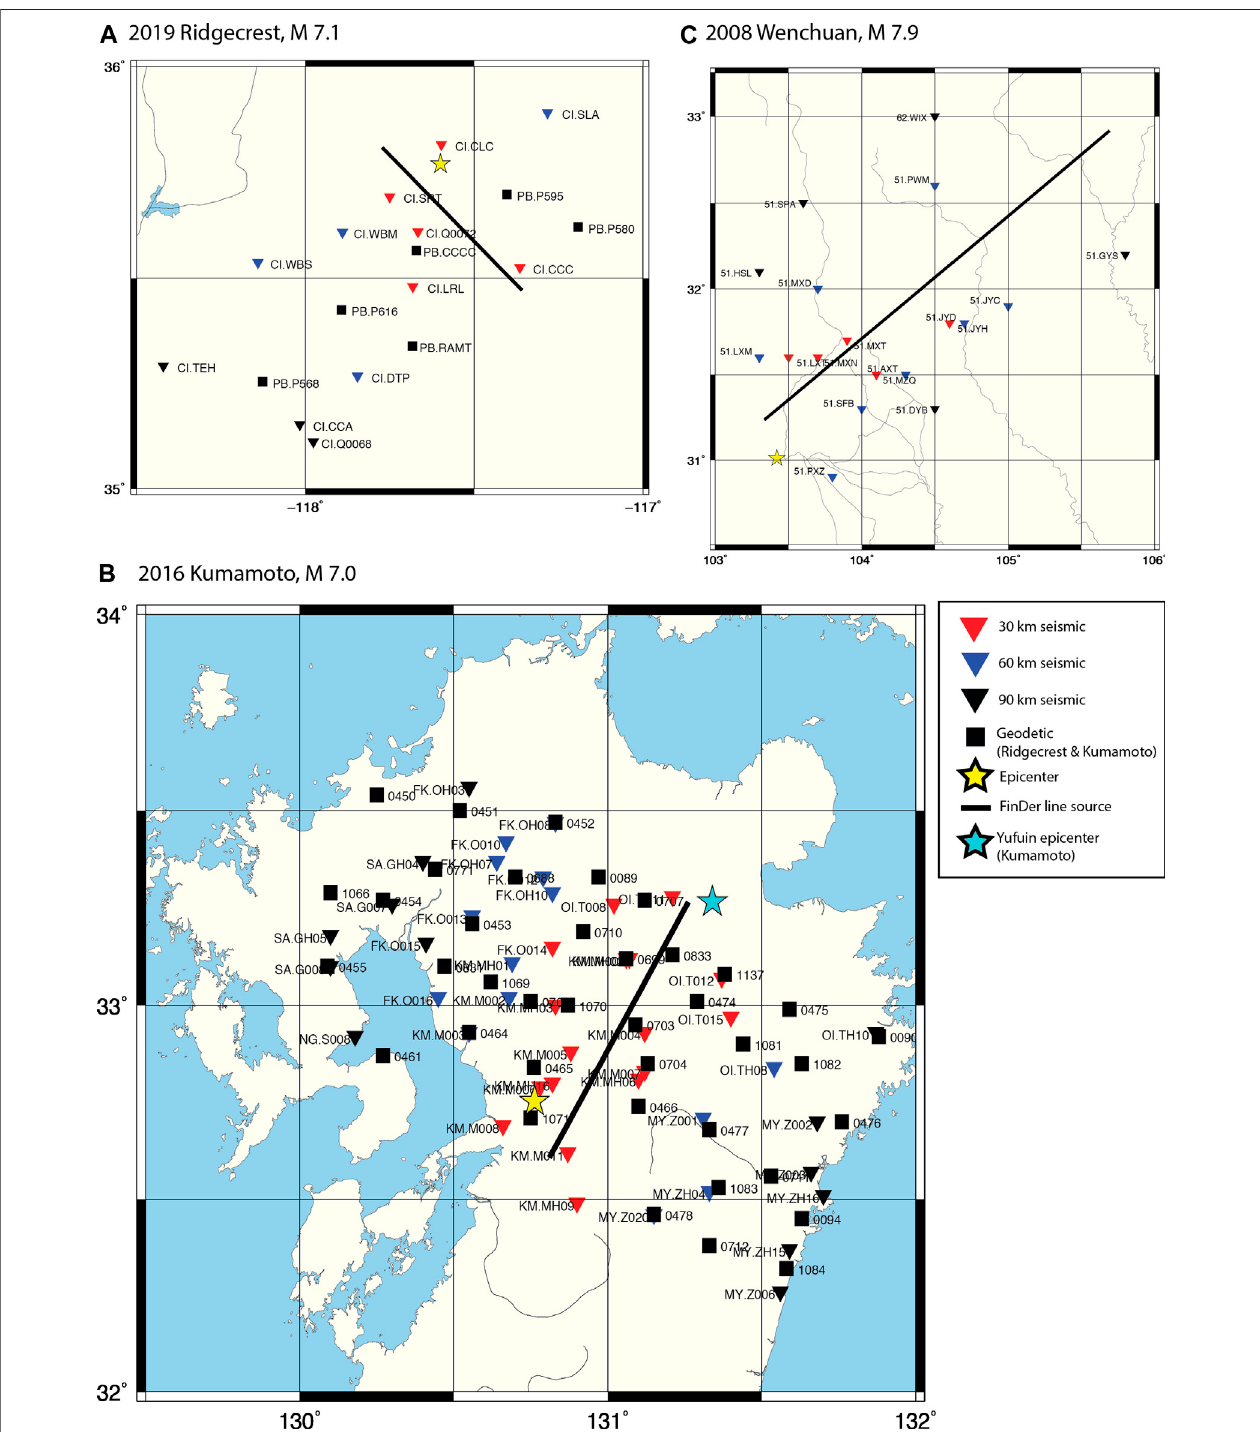
FIGURE 3 | Peak ground displacement (PGD) amplitudes recovered from high-pass fi ltered seismic and geodetic recordings of the Ridgecrest, Kumamoto, and Wenchuan earthquakes, sorted as a function of the closest distance to the fi nal FinDer line-source. Values are listed in Supplementary Table 1 ( Supplementary Material ).Seismic(triangles)andgeodetic(squares)PGDvaluesgenerallyagreewell.InthenewFinDerSandFinDerS+algorithmswebackprojectthetime-varyingPGD amplitudes onto the evolving FinDer line-source to estimate seismic slip pro fi les at any given time through the rupture.